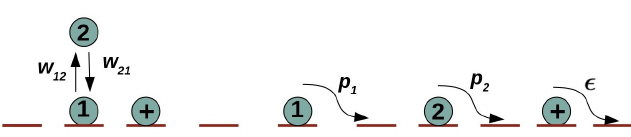
Figure 1: The figure illustrates all possible microscopic dynamical processes for the 2-TASEP-IAF with µ = 2. The species 1 and species 2 particles can hop to right (if vacant) with rates p and p whereas the corresponding hopping rate for the impurity 1 2 ( + ) is ε . The flip process between the species 1 and 2 can occur only in the presence of an impurity at the right neighbor. The corresponding flip rates are w transforming to 2) and w (for 2 transforming to 21